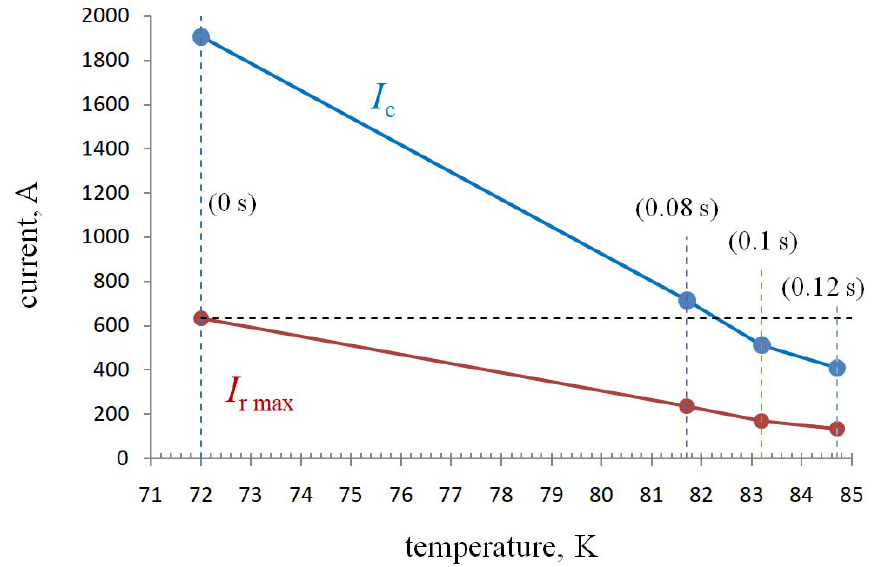
Figure 14. Basic parameters of the limiter— I c and I r max before short-circuit (0 s) and after short- circuits lasting: 0.08 s, 0.1 s and 0.12 s, in accordance with Table 6.